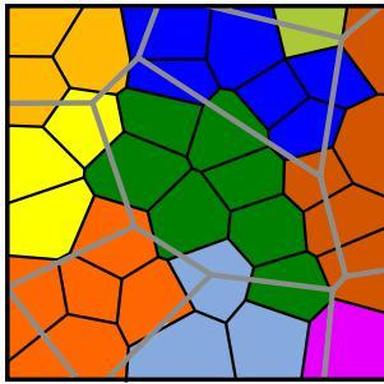
Schematics of the multilevel VORONOI tessellation: Cells from the firstlevel (black lines) are grouped according to a second tessellation (gray lines) to form complex-shaped "grains" (indicated by colors). (For interpretation of the references to color in this figure, the reader is referred to the web version of this article.)